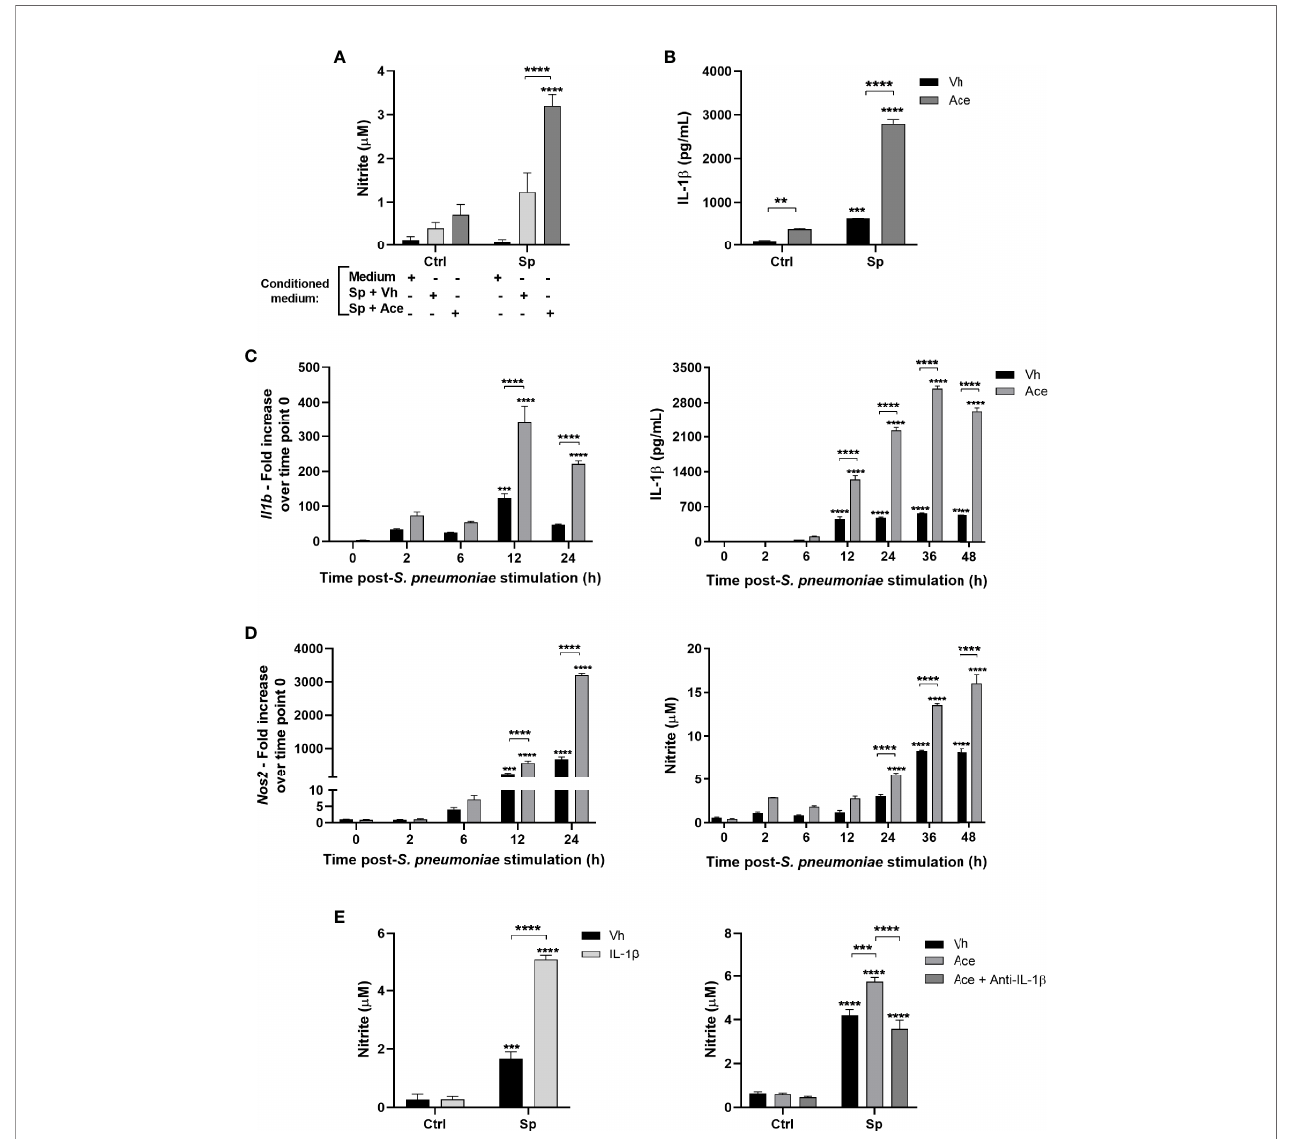
FIGURE 2 | Acetateincreases nitric oxide production via IL-1 b . (A) Nitrite concentration assessed byGriess assay fromsupernatant of MPI cells pre-treated with conditioned medium, then stimulated ornot with S. pneumoniae. Conditioned medium isthe supernatant of MPI cells stimulated with S. pneumoniae inthe presence or absence of acetate during24 h. (B) ELISA of IL-1 b from supernatant of MPI cells pre-treated ornot with acetate and stimulated or not with S. pneumoniae during 24 h. (C, D) Kinetics from MPI cells pre-treated with acetate and then stimulated with S. pneumoniae . Cellular lysate was used for Il1b and Nos2 mRNA quanti fi cation byRT-PCR, andsupernatants for IL-1 b secretion byELISA and nitrite byGriess assay.For RT-PCR fold increase was calculated over time point 0 (Vh). (E) Nitrite concentration assessed byGriess assay from supernatant ofMPI cells: Pre-treated ornot with IL-1 b and stimulated or not with S. pneumoniae during24 h (E) left panel). Pre-treated or not with acetate and/or anti-IL-1 b antibodyand stimulated of not with S. pneumoniae for 48 h (E) right panel).Barsshowingthe mean anderrorshowing the SEM oftriplicates. Results are representative ofthree independentexperiments. Statisticalanalysiswas done using Two-way ANOVA corrected with Sidak ’ s multiplecomparisonstest (**p < 0.01, ***p < 0.001, ****p <